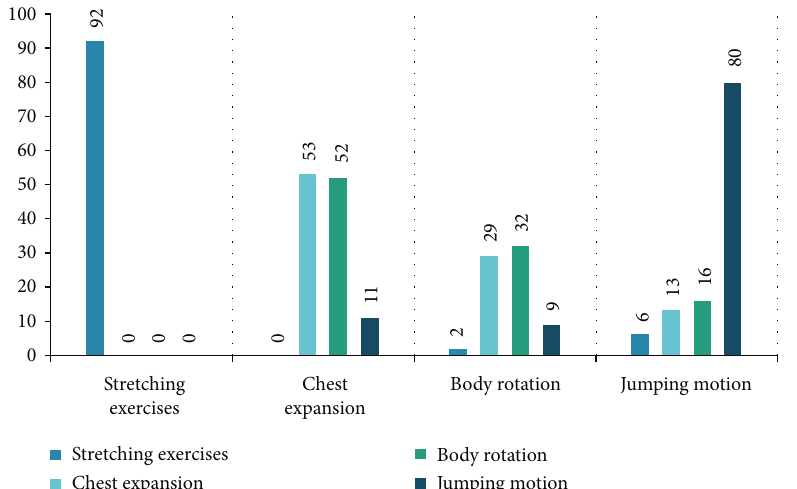
Figure 7: Confusion matrix training analysis results.